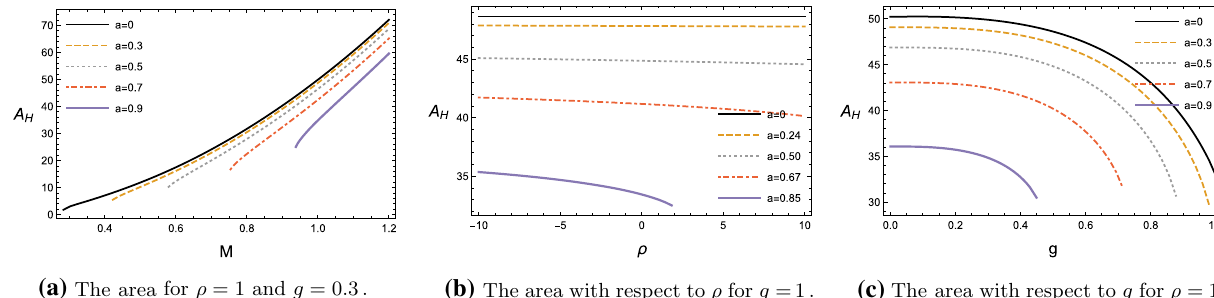
starts to disappear at the equator. Hence, the coverage